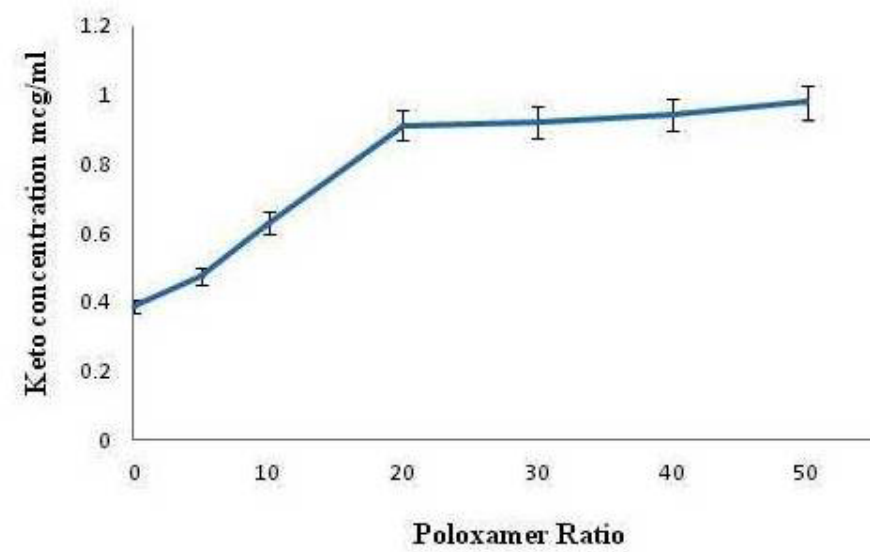
FIGURE 1 - Phase solubility of Ketoprofen:Poloxamer 188.